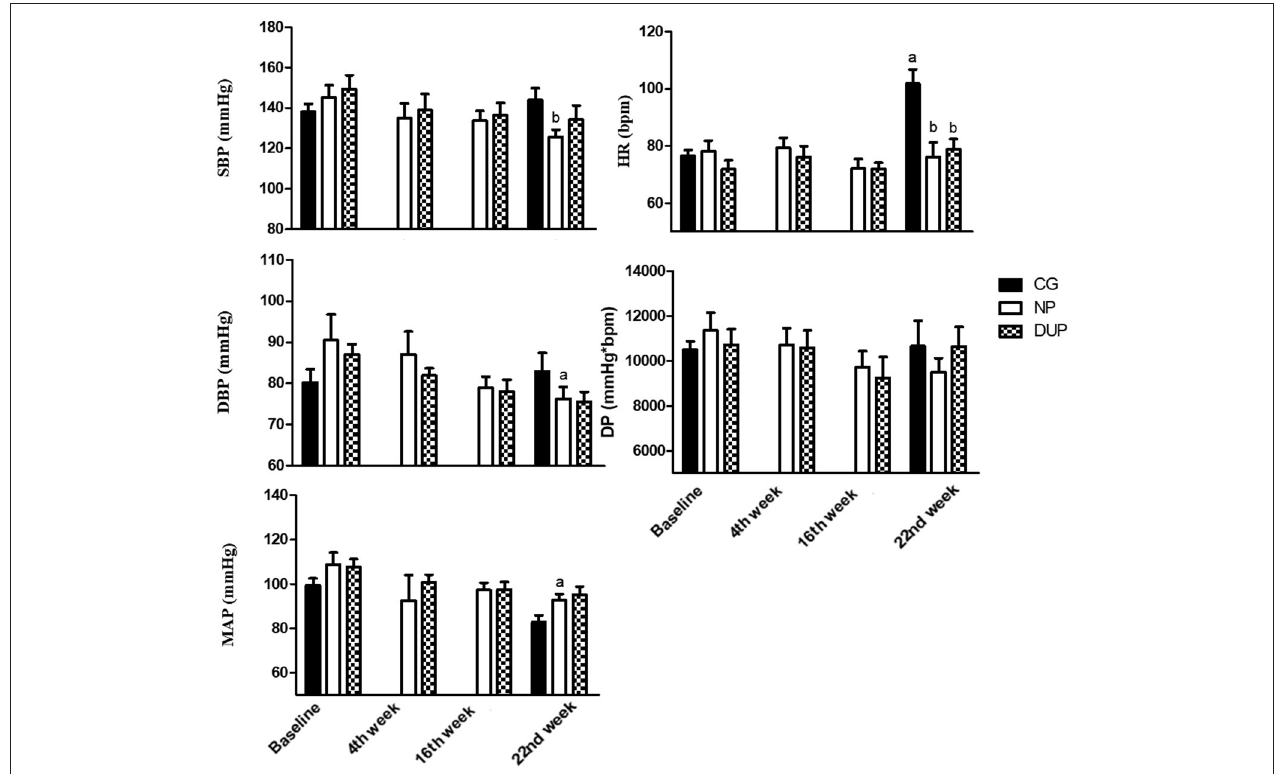
FIGURE 3 | Hemodynamic parameters of experimental groups in the overall sample. Values expressed as mean ± SD.NP, Non-periodized; DUP, Daily undulating periodization; CG, Control group; SBP, Systolic blood pressure; DBP, Diastolic blood pressure; MAP, Mean arterial pressure; HR, Heart rate; DP, Double product; a P < 0.05 vs. Baseline; b P < 0.05 vs. CG in the 22nd week. An ANOVA [3 × 2, groups × time] was used to examine differences between NP, DUP and CG pre and post-exercise. An ANOVA [2 × 4, groups × time] was used to examine differences between NP and DUP over the 4 measurement moments (Baseline, 4th week, 16th week, and 22nd week). Dunnet was performed as the post-hoc